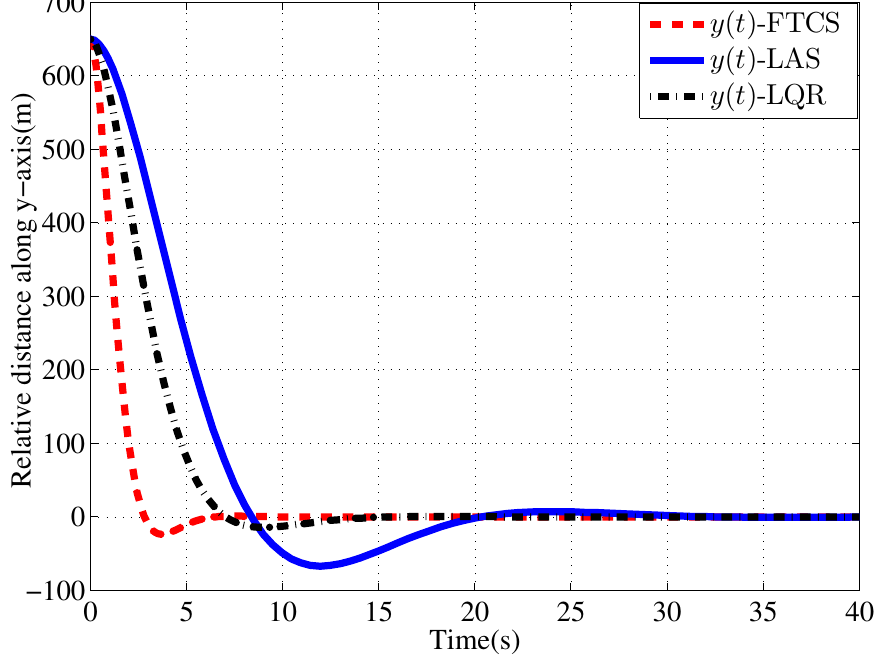
Figure 4. Relative position along y -axis under different control